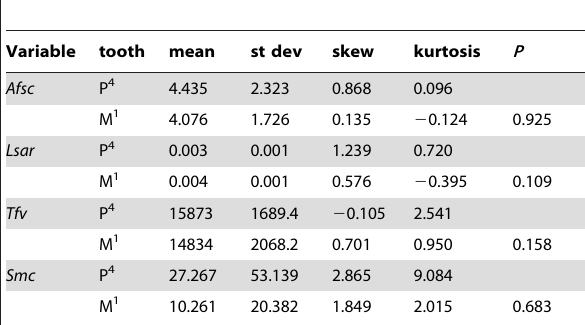
Table 2. Dental Microwear Attributes of P 4 and M 1 in Cercocebus atys